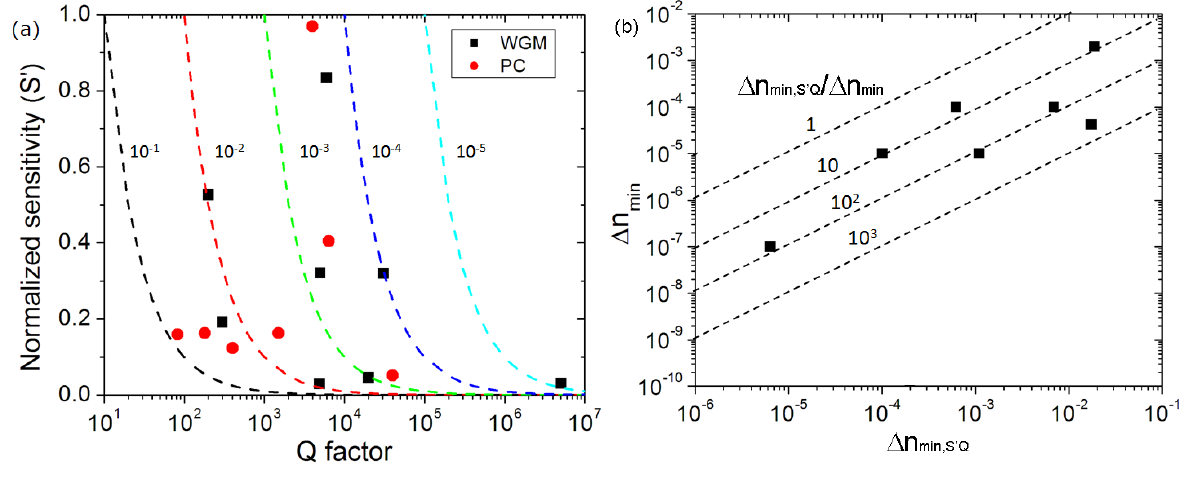
Figure 3. (a) Normalized sensitivity S’ versus Q factor. The data are collected from some papers on 1D photonic crystal nanobeam, 2D photonic crystal slab, microdisk, and micro-toroid optical resonators [27-40]. Dashed lines are contour lines of the value (b) System minimum detectable index change dashed lines represent the improvement factor, i.e.